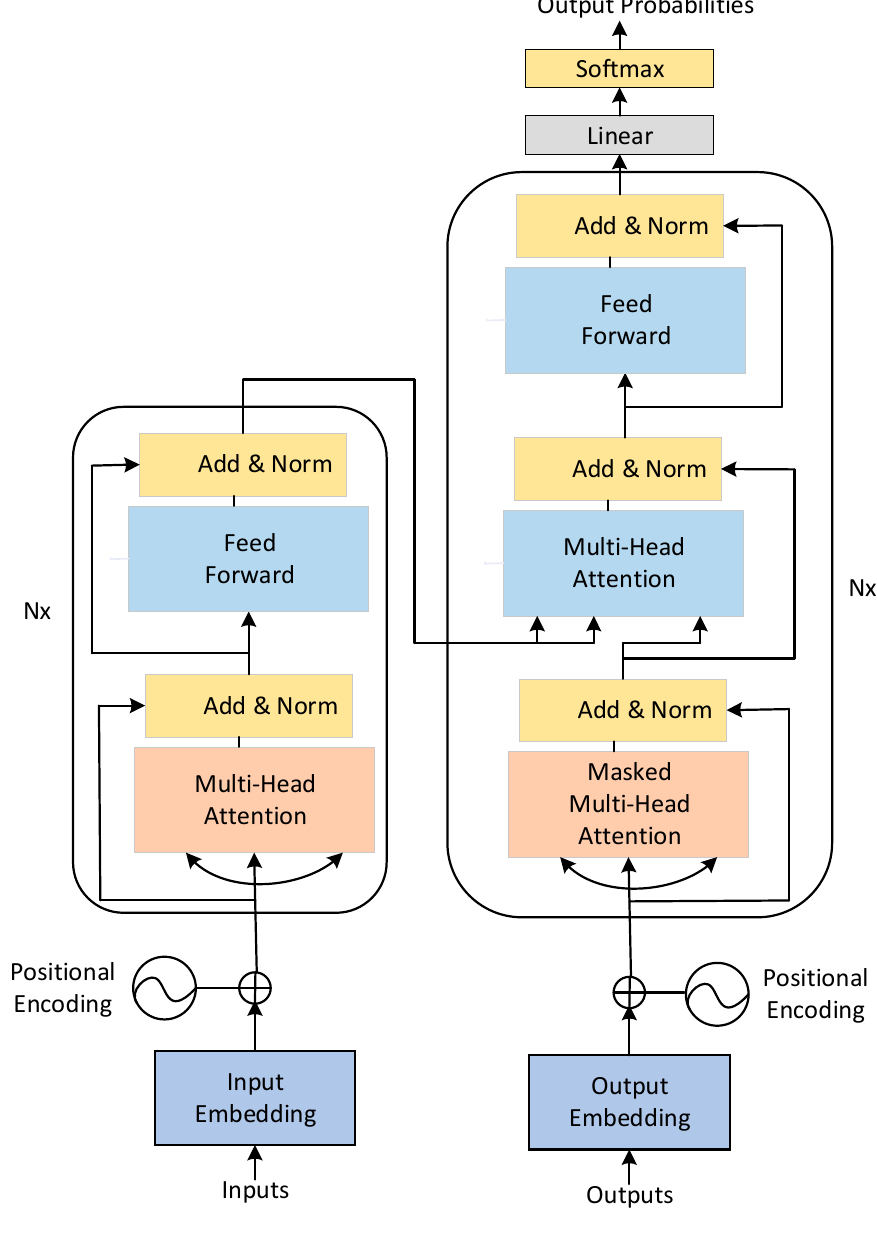
Figure 3. The structure of Transformer